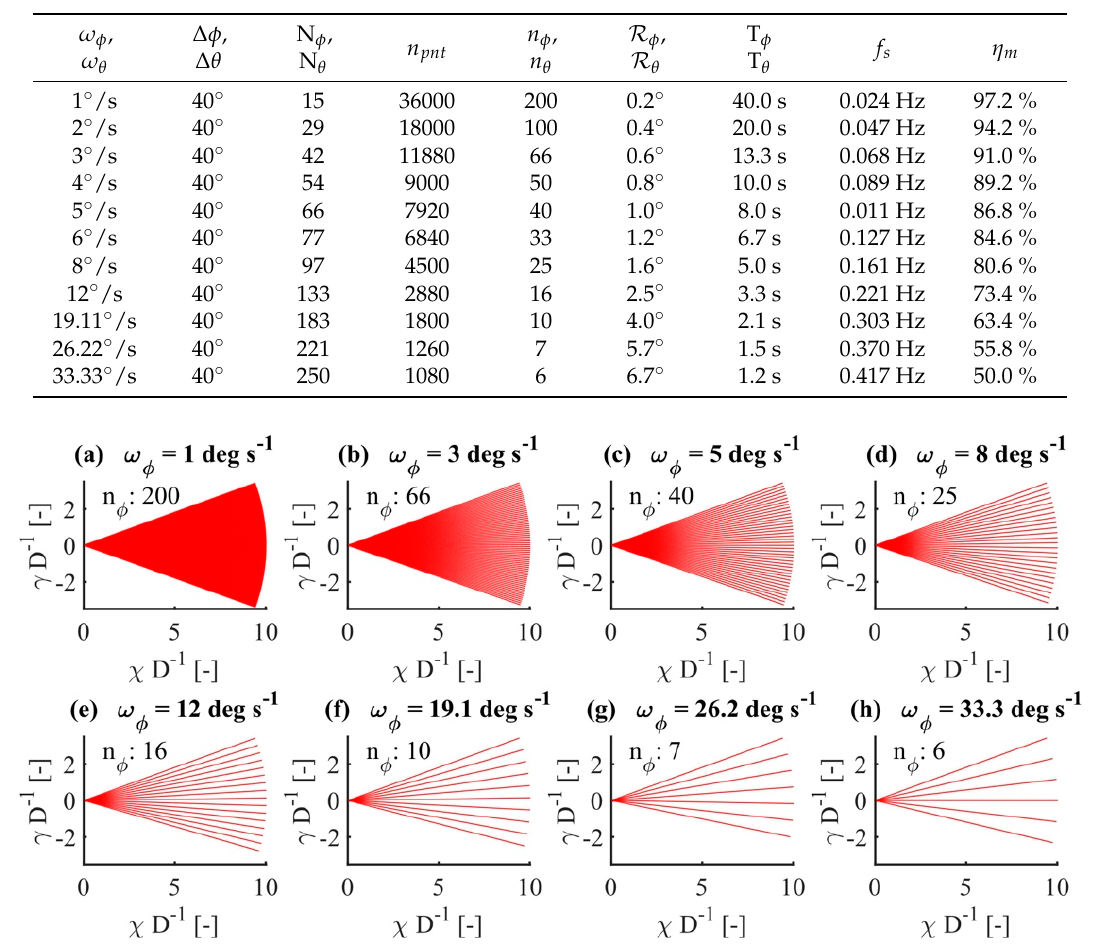
Figure 2. Illustration of the polar measurement grid of a PPI scan in the Cartesian χ - γ coordinate system. Each sub-figure plots the grid density for eight out of a total of eleven different angular velocities ( ω φ ). Table 1. Simulated LiDAR trajectories of cross-measurements for 𝑛 (cid:3045) = 180 and T = 600 s .